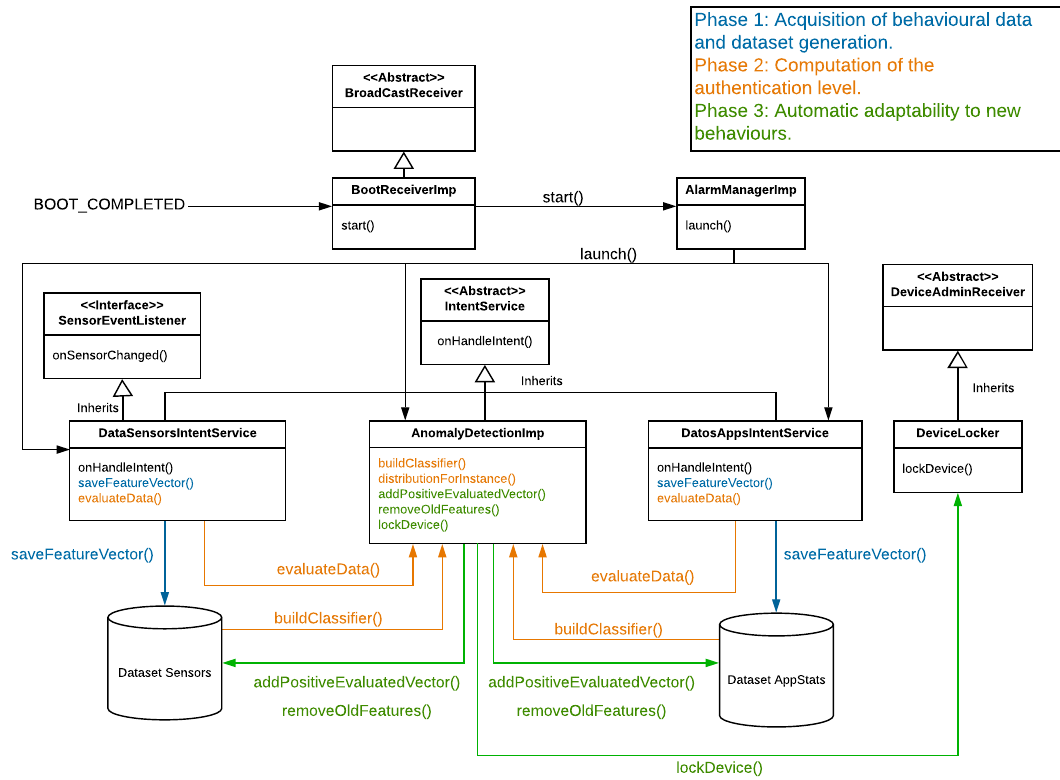
Figure 2. Diagram of the most important classes and processes of the